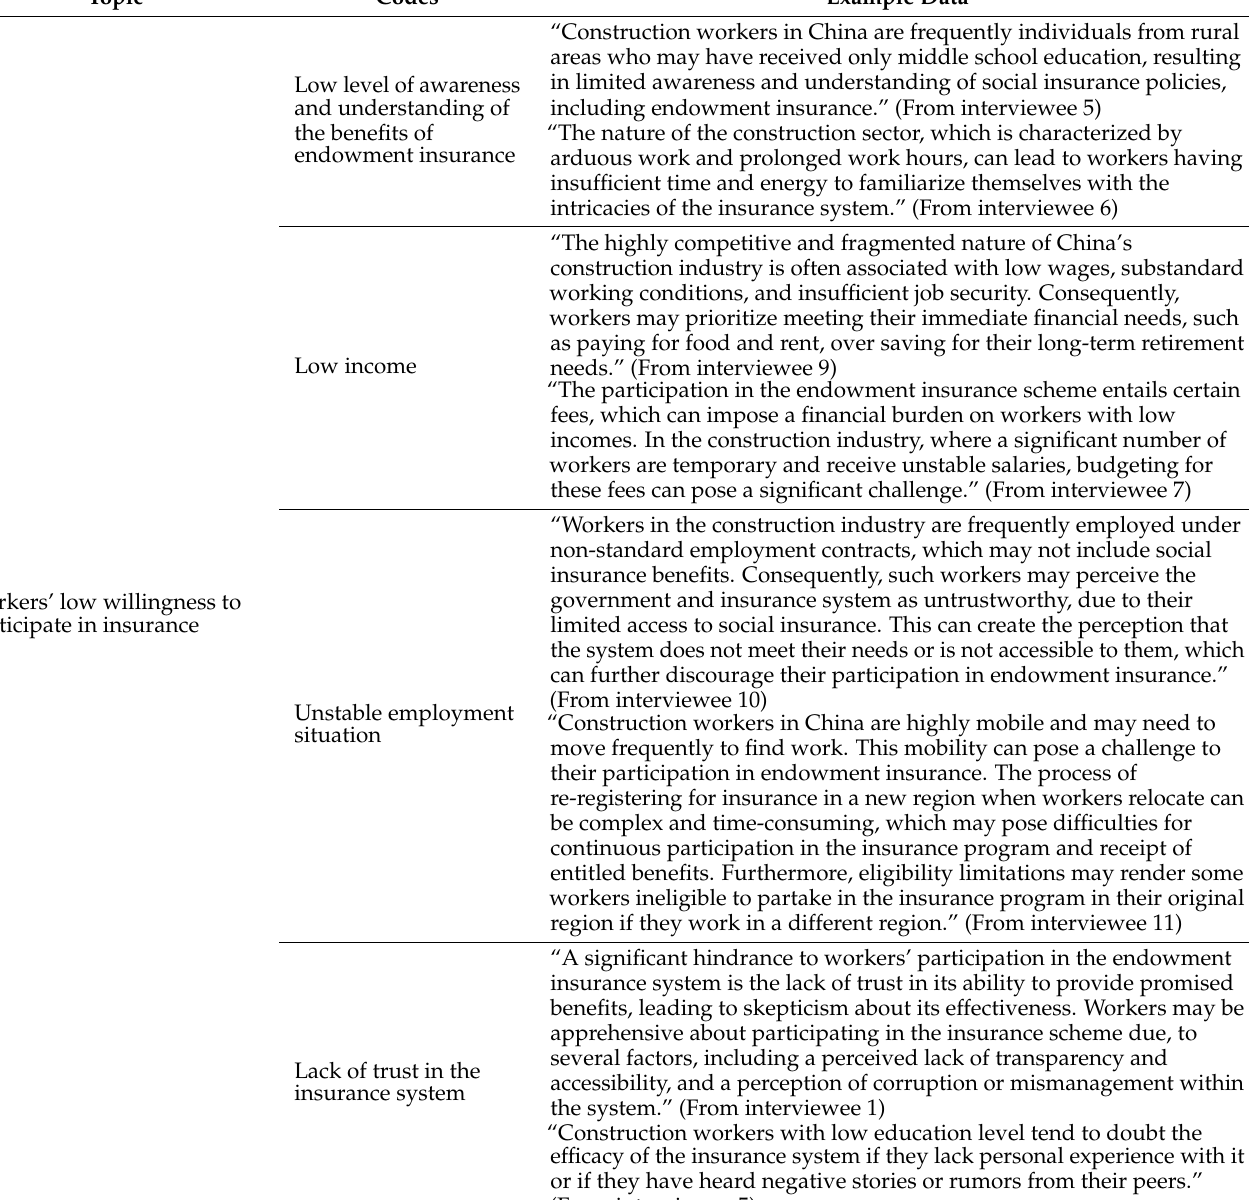
Table 2. Thematic analysis process of